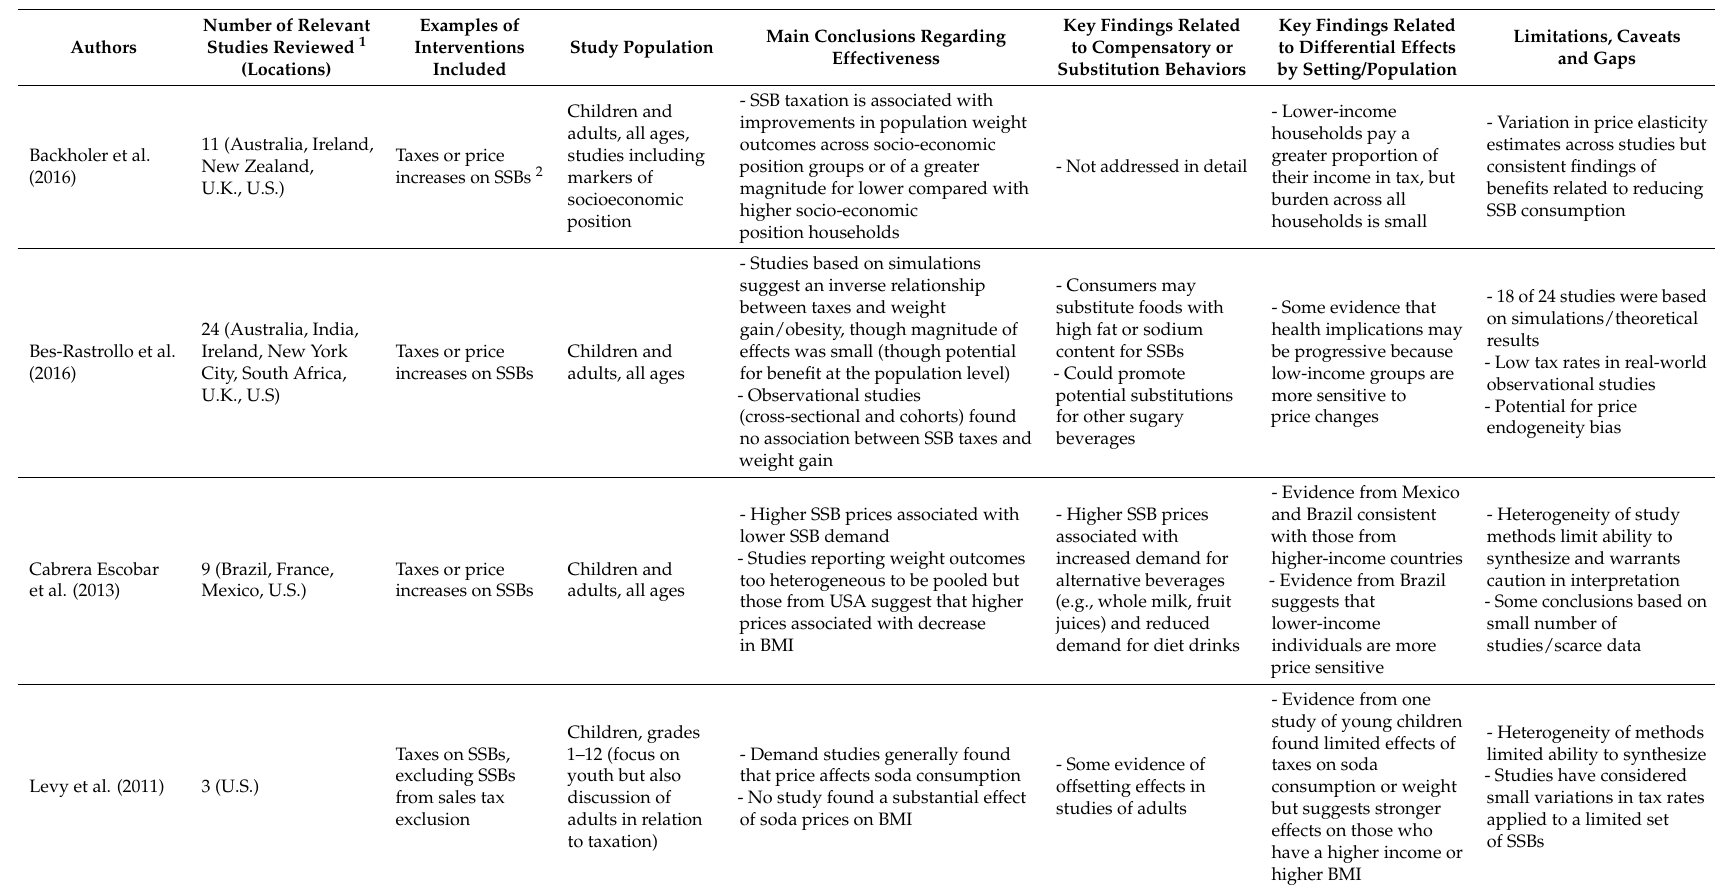
Table 2. Overview of evidence on interventions influencing price ( n = 6